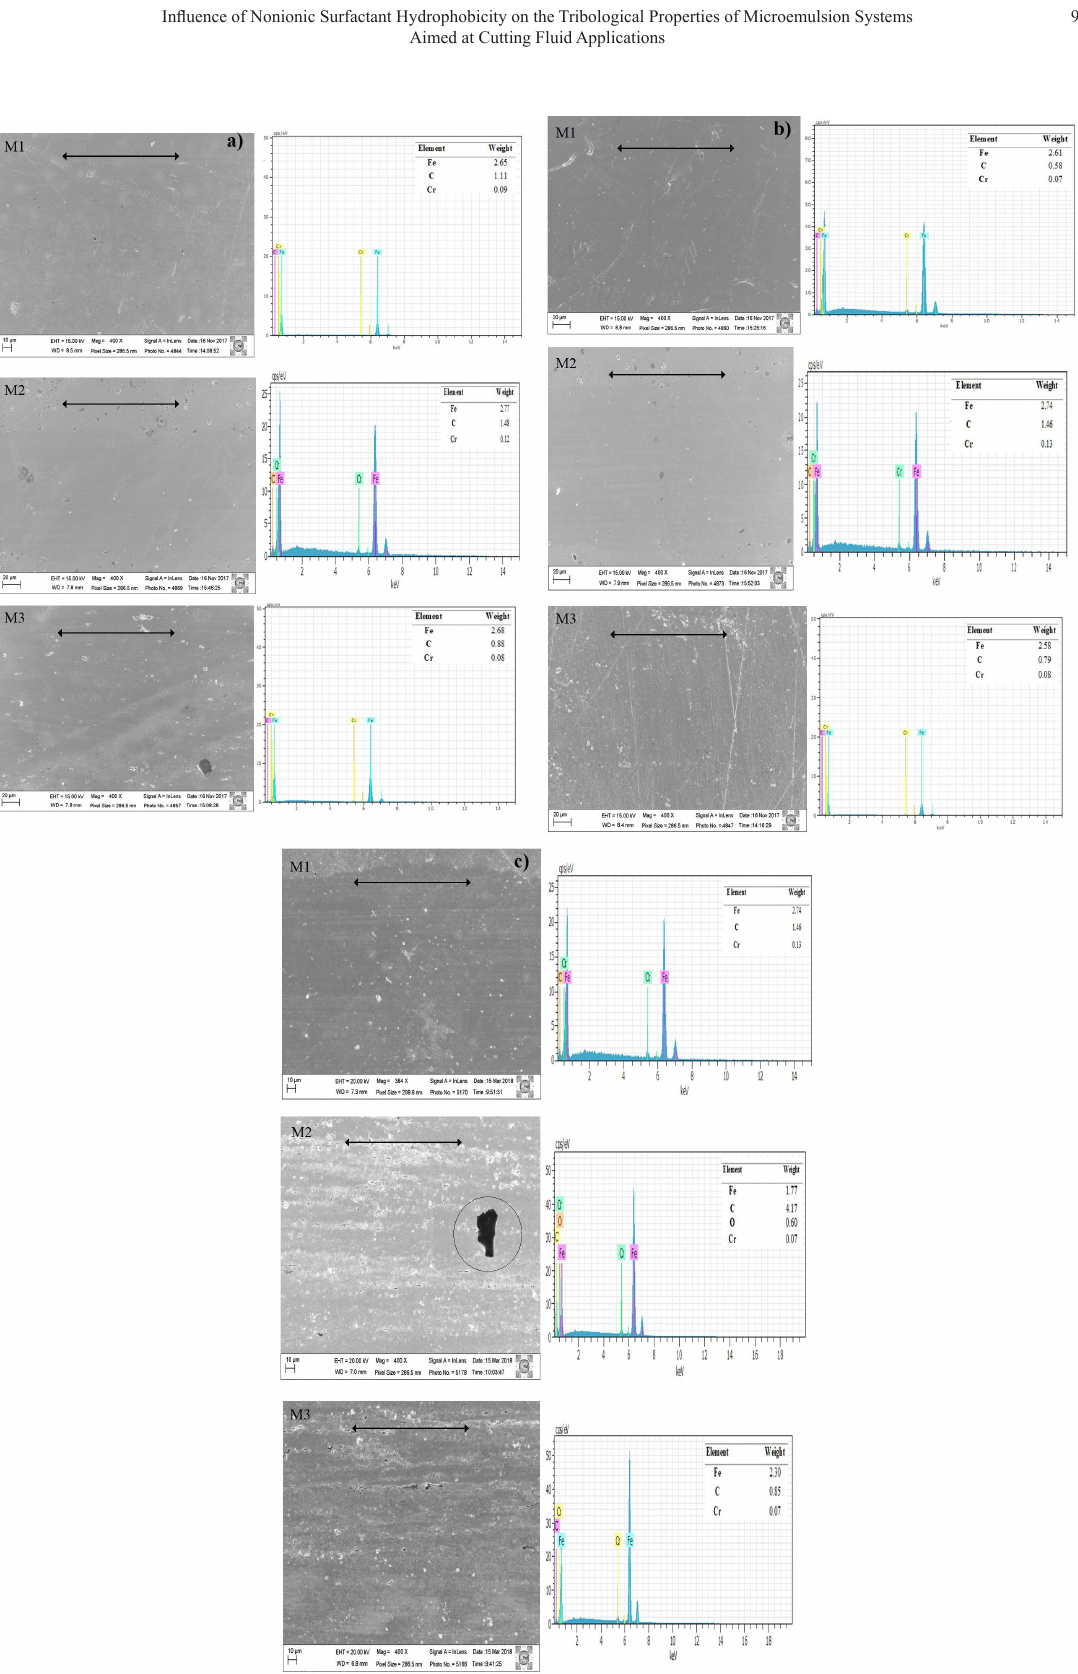
Figure 9. SEM/EDS analyses of worn surfaces lubricated with the microemulsion systems of different compositions (M1, M2 and M3) formulated with surfactants: (a) NP4EO, (b) NP6EO and (c)